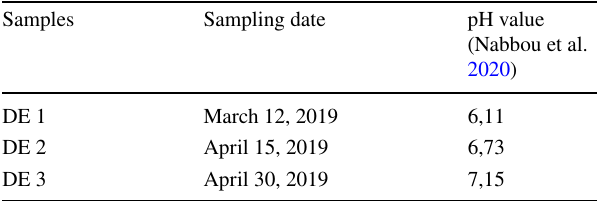
Table 1 Frequency and date of sampling of dairy effluents